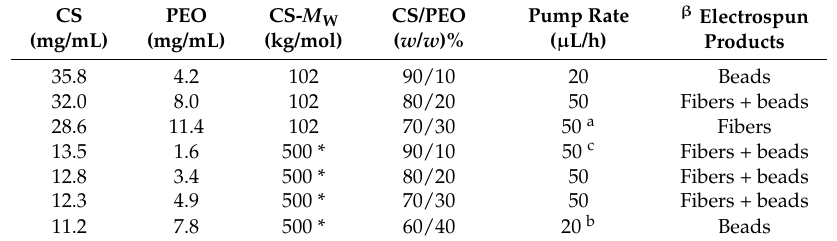
Table 3. Electrospun blends of chitosans having different molecular weights with PEO (1000